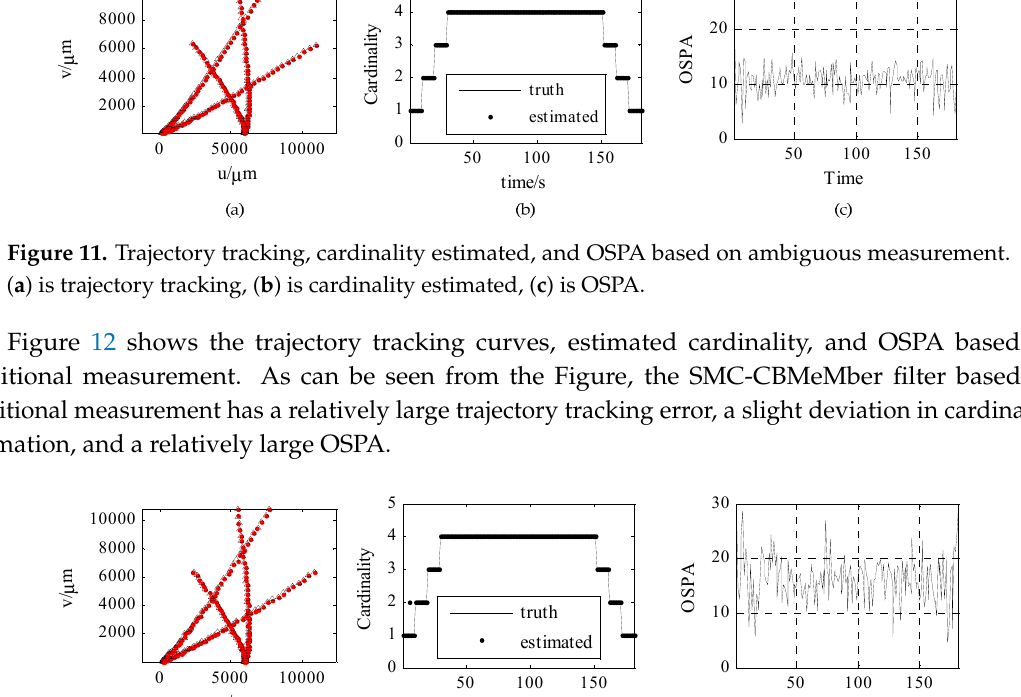
Figure 12. Trajectory tracking, cardinality estimated, and OSPA based on traditional measurement. ( a ) is trajectory tracking, ( b ) is cardinality estimated, ( c ) is OSPA. 0